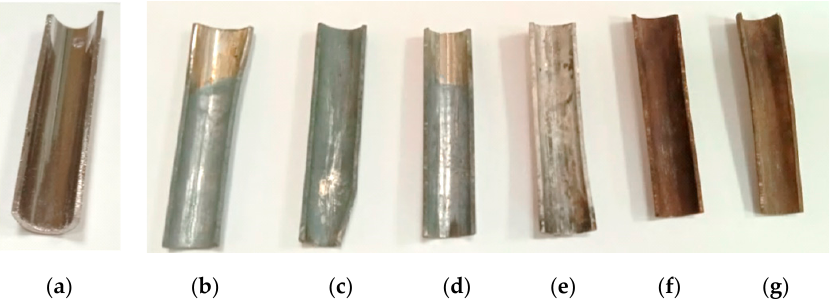
Figure 2. Appearance of the studied samples. ( a ) The original sample; samples were aged in a FLiNaK melt at a concentration of О 2 − : ( b ) 500 ppm, ( c ) 1000 ppm, ( d ) 1500 ppm, ( e ) 2500 ppm, ( f ) 4500 ppm, ( g ) 8000 ppm.